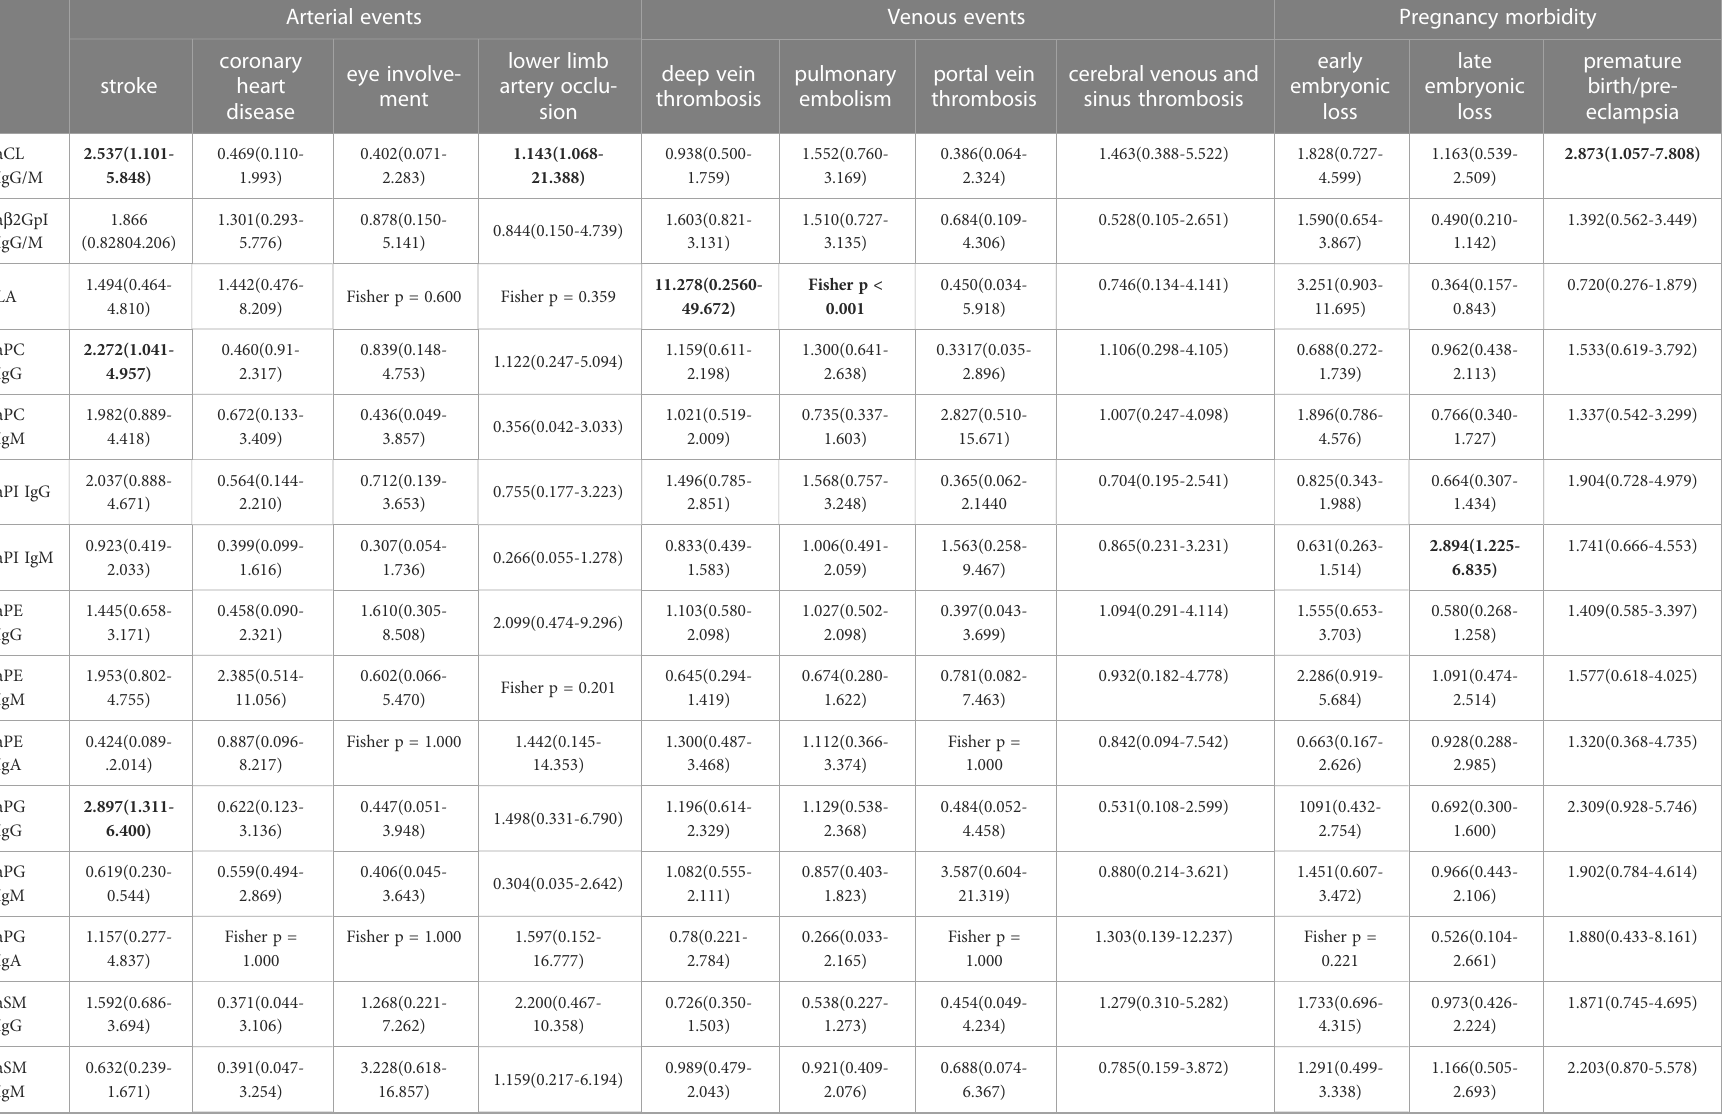
TABLE 3 Clinical correlations between non-criteria aPLs and criteria clinical manifestations (n =